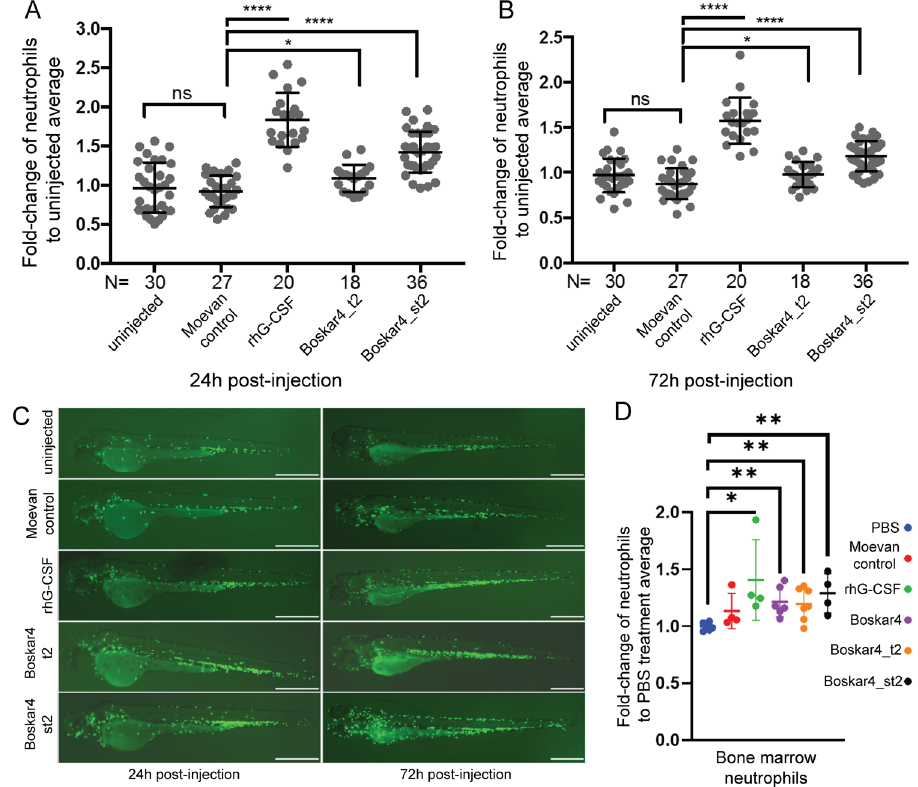
Fig. 8 The designs show in vivo activity in zebra fi sh and mouse models. A , B Interval plots of the fl uorescent neutrophils in zebra fi sh ( Tg:mpxGFP ) that were either not injected, or injected with the inactive protein Moevan_control, rhG-CSF, Boskar4_t2, or Boskar4_st2, after ( A ) 24 h or ( B ) 72 h of treatment. Data show mean ± standard deviation, and the number of treated embryos under each condition is show as N (under the x -axis), * p < 0.05, or **** p < 0.0001 vs. the Moevan_control group ( p -values are listed in Supplementary Table 4). C Representative images of 1- and 3-day embryos that were not injected, or injected with inactive protein (Moevan_control), Boskar4_t2, or Boskar4_st2. Fluorescently labelled neutrophils can be observed and quanti fi ed across the tail region (scale bar: µ m). D Ly5.1 mice were treated with PBS, the inactive protein Moevan_control, rhG-CSF, Boskar4, Boskar4_t2, or Boskar4_st2 ( n = 7 per group for each condition). Fold change of mouse neutrophils (DAPI - CD45 + Ly6G + Ly6C + ) in the bone marrow of treated mice compared to PBS group is shown. Statistical signi fi cance was calculated by Fisher ’ s two-sided t -test (* p < 0.05, or ** p < 0.01 vs. the PBS group). The exact p- values are provided in the source data fi